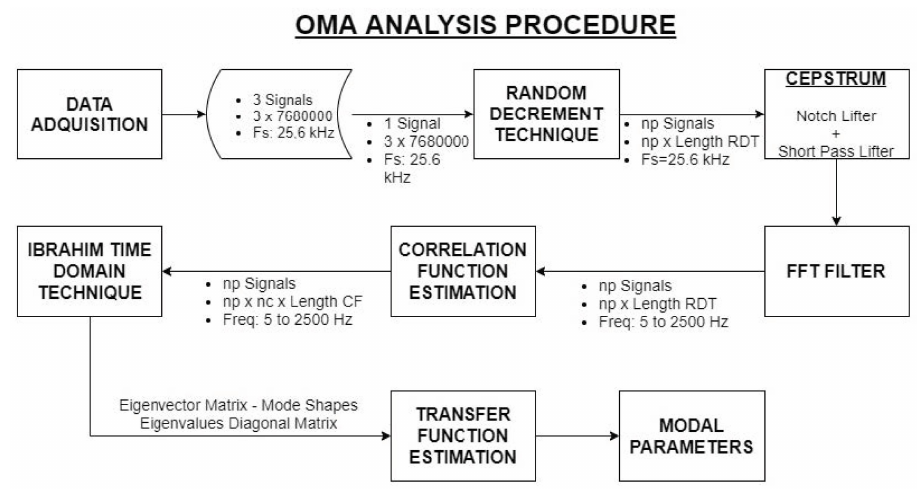
Figure 7. Flowchart of the overall OMA analysis procedure.